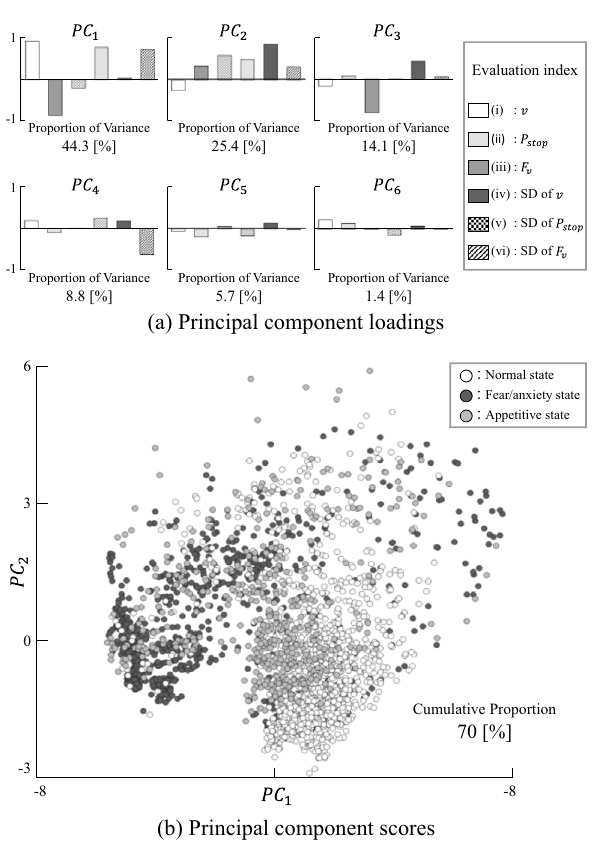
Figure 7. PCA results. The data for the fear/anxiety state are closely grouped in the bottom left-hand portion of the space and are distributed differently from the data for the normal state. The data for the appetitive state are widely distributed throughout the